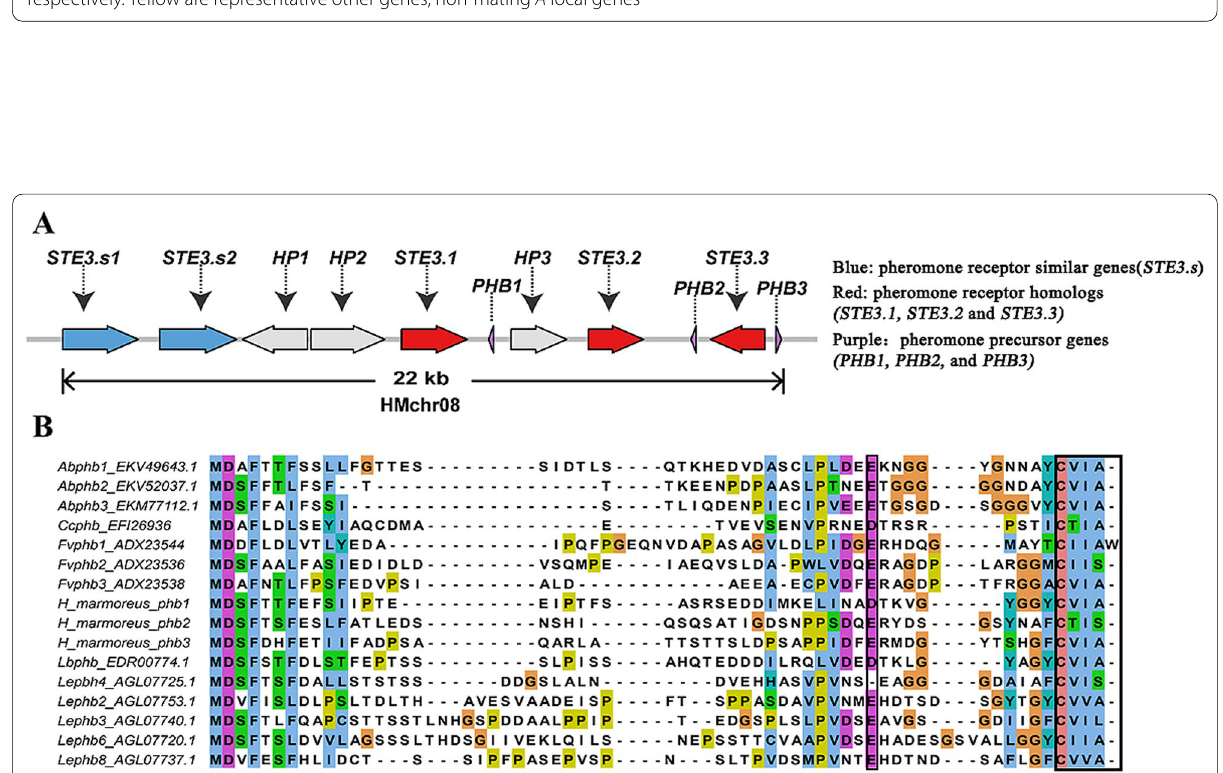
Fig. 5 The mating P/R loci structure and pheromone precursor protein. A The mating P/R loci structures. The gene names shown above each arrow. B Alignment of the pheromone precursor amino acid sequences from H. marmoreus , C. cinerea (Cc), L. bicolor (Lb), A. bisporus (Ab), L. edodes (Le), and F. velutipes (Fv), showing typical conservation of the CAAX motifs, and a Glu (E) at a position 10 AA upstream from the CAAX motif, which are both needed for proper